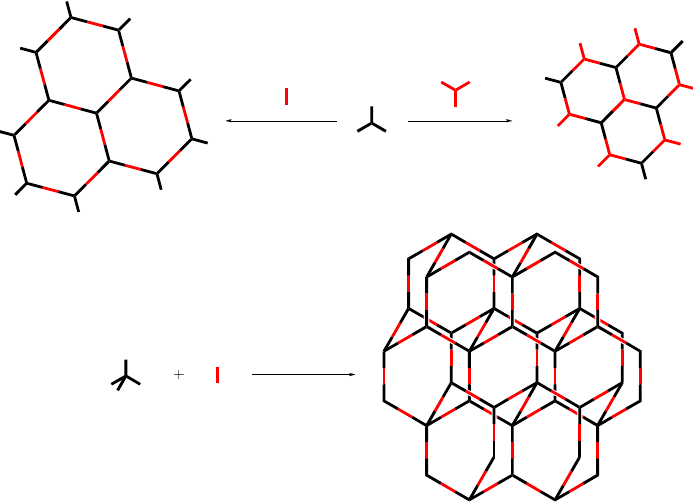
Figure 2. The most common topologies on layered 2D and 3D COFs.